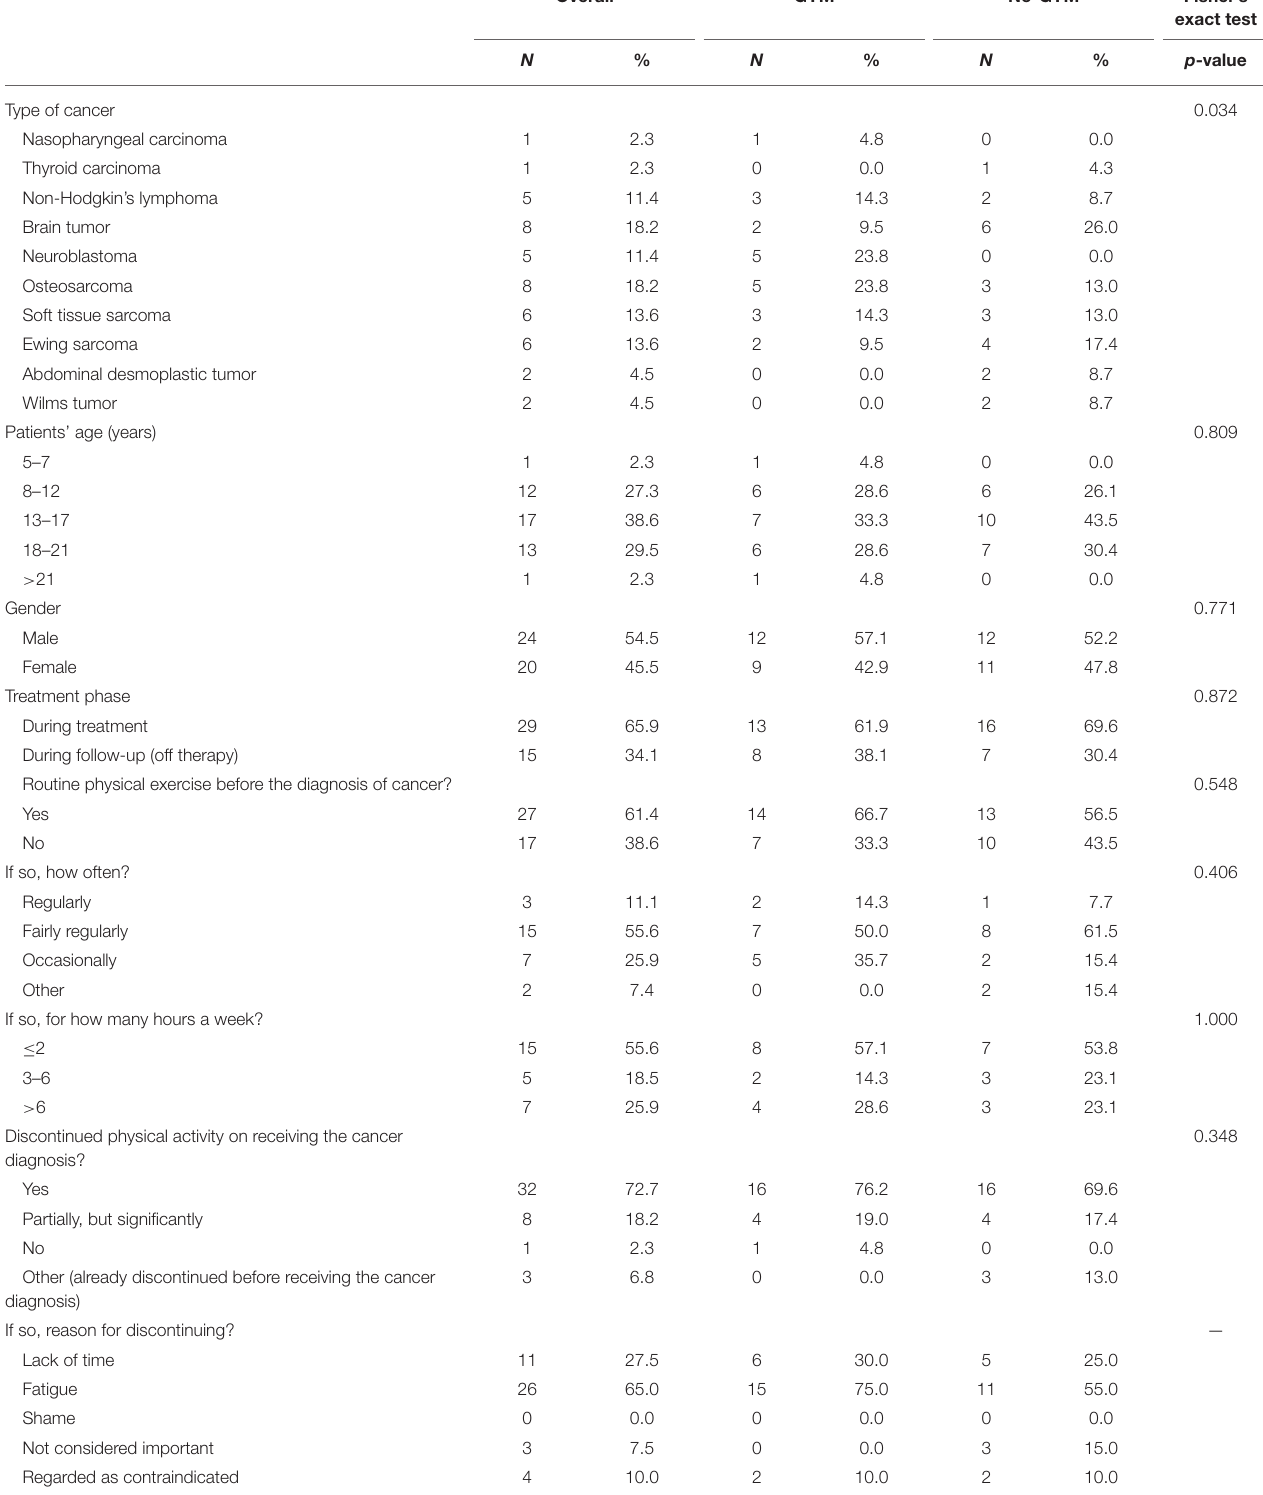
TABLE 1 | Patients’ characteristics and their answers in the general questionnaire, overall and by